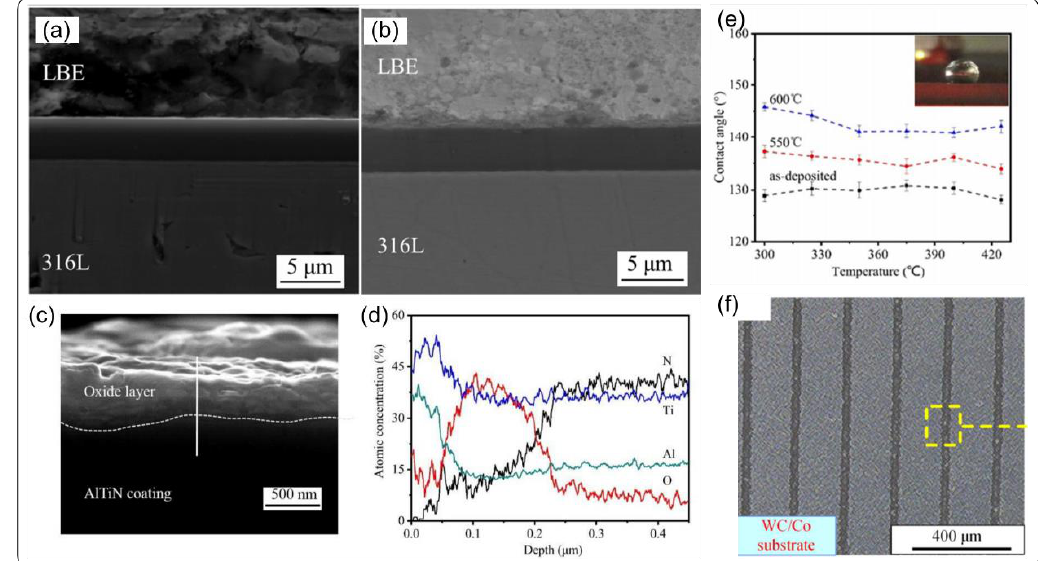
Figure 10. Corrosion performance of TiAlN coating in liquid LBE. ( a ) morphology of TiAlN coating after 500 °C, 500 h LBE corrosion; ( b ) topography of TiAlN coating at 600 °C; ( c ) topography of oxide layer on high-multiplier surface; ( d ) distribution of oxide layer elements; ( e ) wetting performance of TiAlN coating and LBE at 290~430 °C; ( f ) microscopic grooves on the surface of a carbide substrate [83,85]. Figure 10a–e is reprinted with permission from [83]. Copyright 2020 Elsevier. Figure 10f is reprinted with permission from [85]. Copyright 2018 Elsevier.